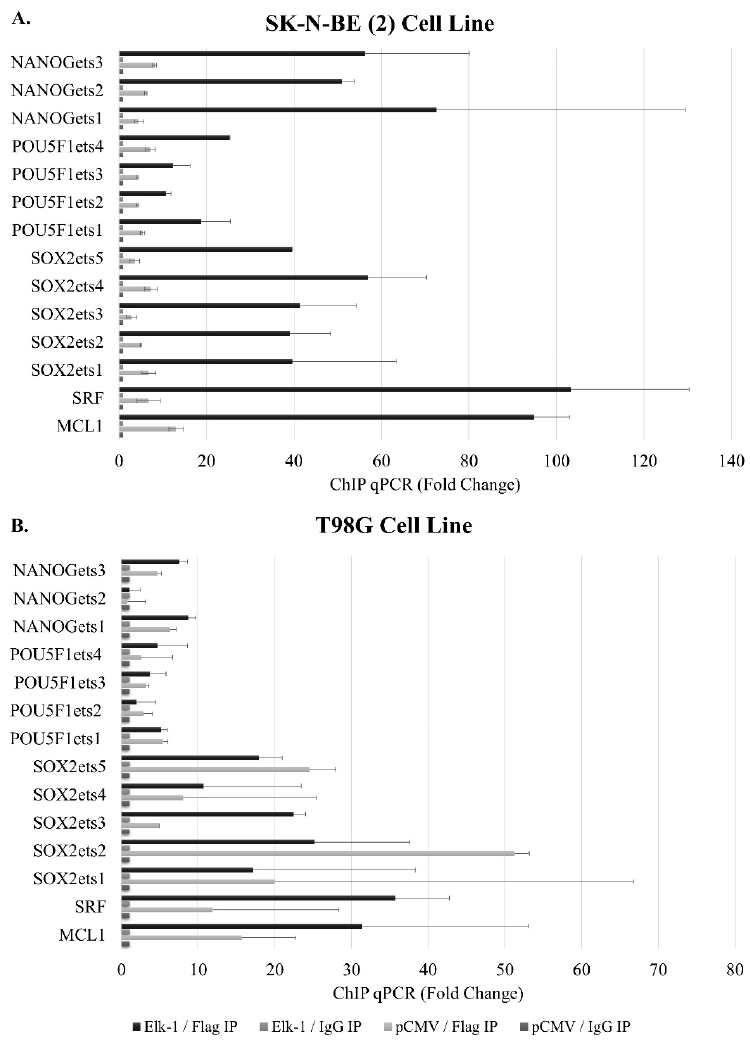
Figure 8. Chromatin immunoprecipitation assay for the identification of Elk-1 binding sites on the target gene promoters in pCMV-transfected (pCMV) vs. Elk-1 over-expressing cells (Elk-1) in ( A ). SK-N-BE (2) cells and ( B ). T98G cells. Lysates were immunoprecipitated with either Flag antibody (Flag IP) for exogenous Elk-1 or IgG (IgG IP) as control. qPCR results were analyzed as explained in Materials and Methods and reported as average fold change. All predicted ets motif sequences on NANOG , SOX2 , and POU5F1 promoters were screened for Elk-1 binding; SRF and MCL1 promoter sequences were used as positive control.